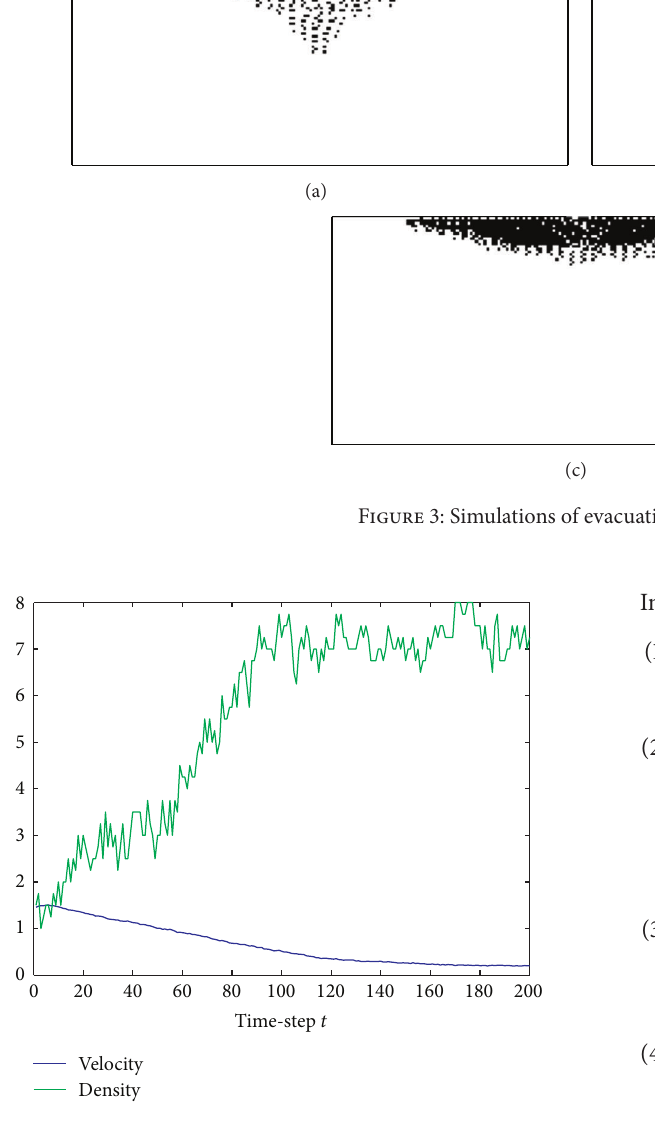
Figure 4: Velocity-time relation and density-time